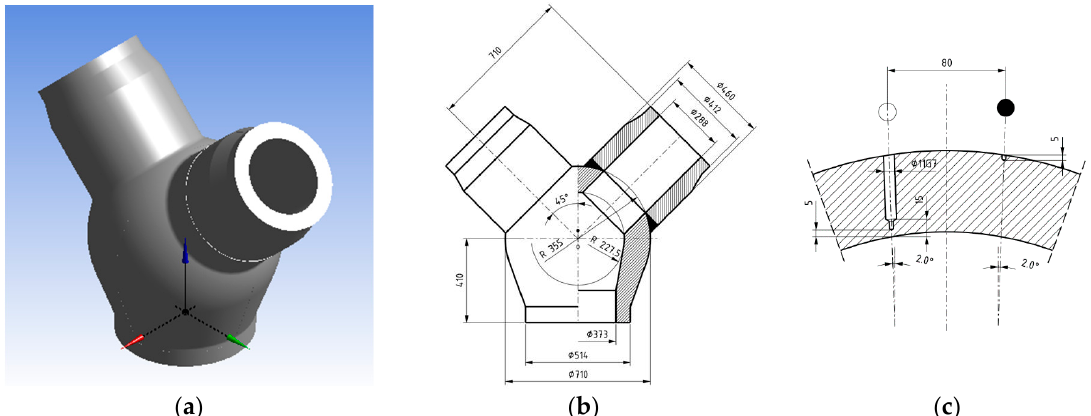
Figure 1. Geometrical characteristics of the considered Y-shaped junction: ( a ) view of the Y-shaped junction, ( b ) cross-section of the Y-shaped junction, ( c ) method of making holes for thermocouples.